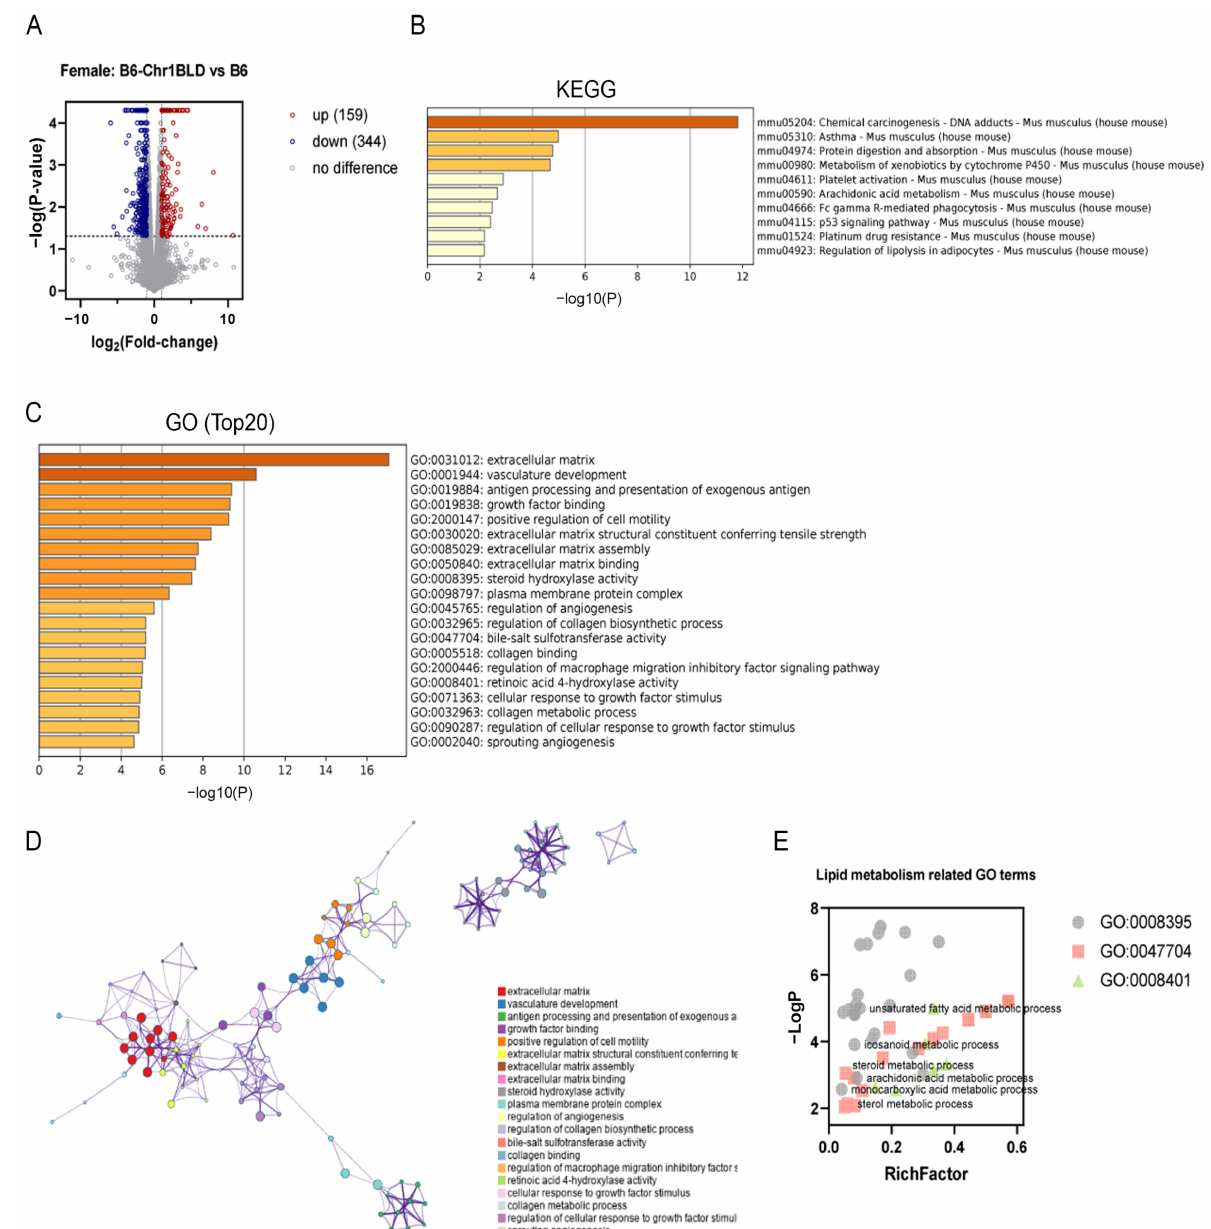
Figure 7. Transcriptome analysis of livers from female B6-Chr1BLD mice. ( A ) Volcano plot of DEGs from female B6-Chr1BLD mice and female B6 mice. ( B ) Enriched KEGG terms. ( C ) Top 20 enriched GO terms. ( D ) Enriched ontology clusters colored by cluster ID. ( E ) Lipid metabolism-related GO